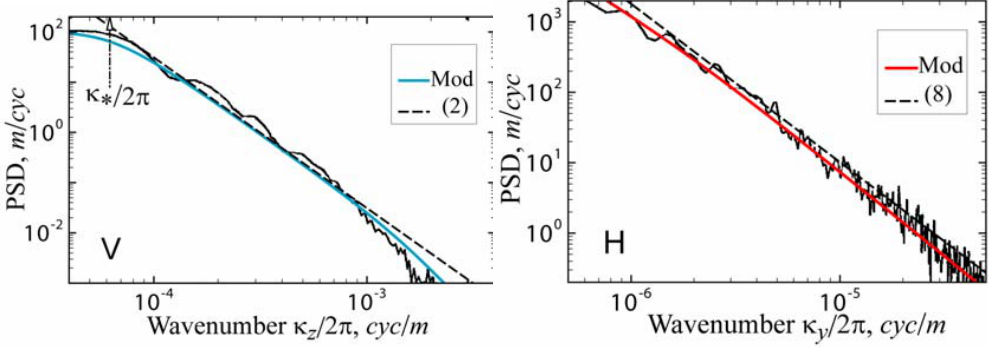
Fig. 3. Comparison of the model with the measurements (Hostetler et al., 1991). Vertical (V) and horizontal (H) spectra of the relative density fluctuations are shown. Black solid line: measurements; Mod: model; the equations used to calculate asymptotic power-law functions are referred to in brackets.